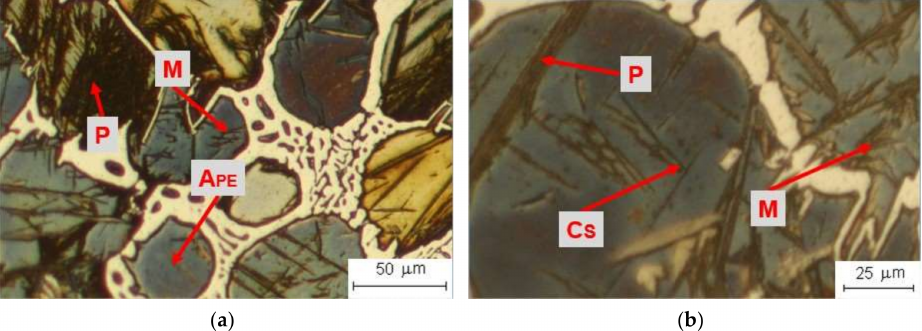
Figure 4. Attack 3 (Marshall reagent for 60 s at room temperature) + 5% ammonium persulfate at room temperature: ( a ): general view at 200 × ; ( b ) detail at 500 × .